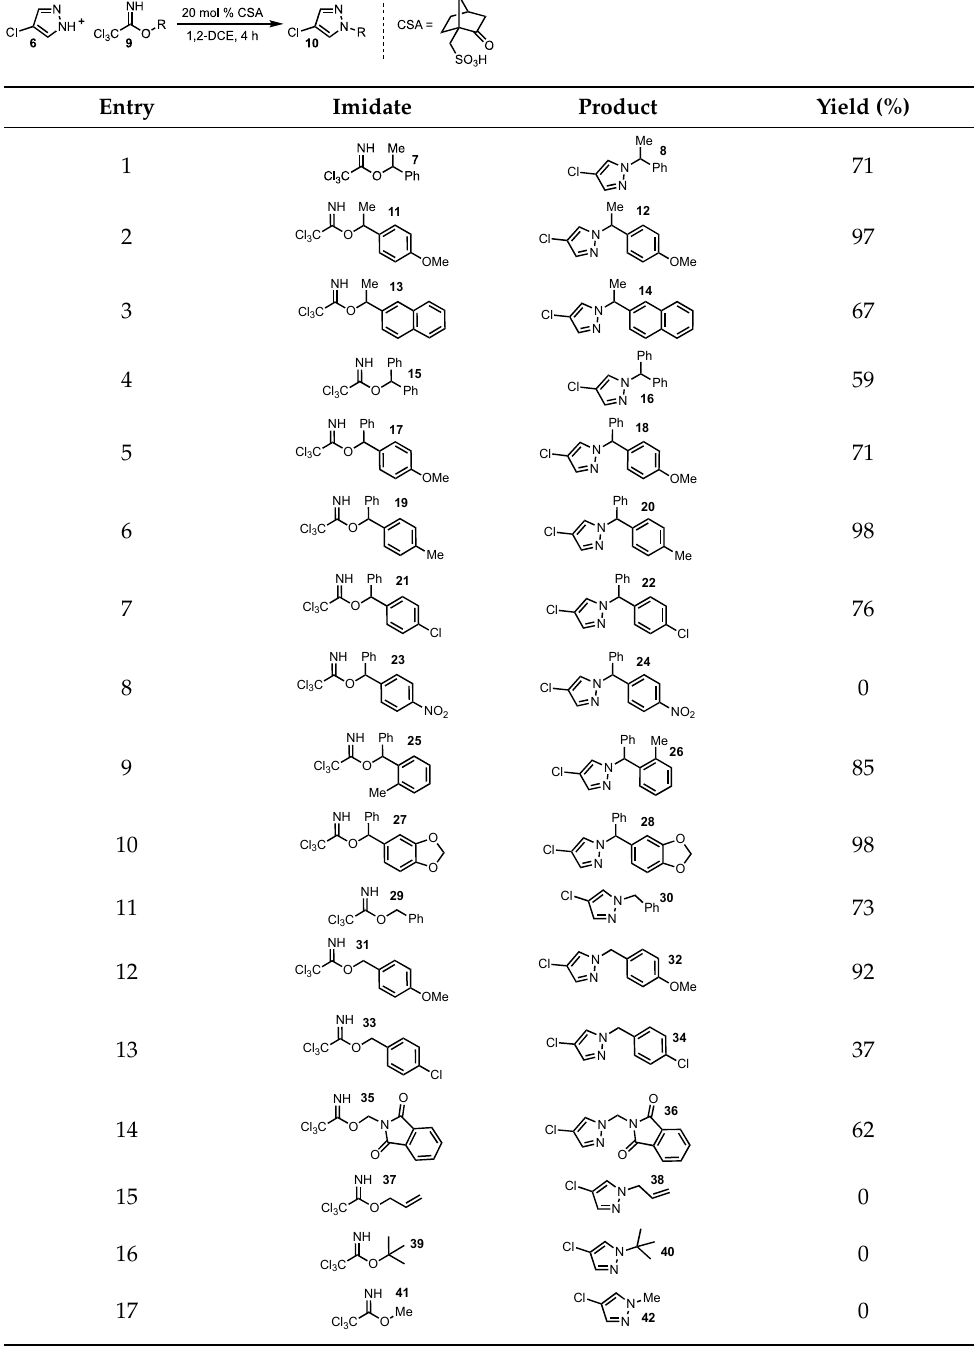
Table 2. N -Alkylation of 4-chloropyrazole 6 with trichloroacetimidates. Entry Imidate Product Yield (%) 1